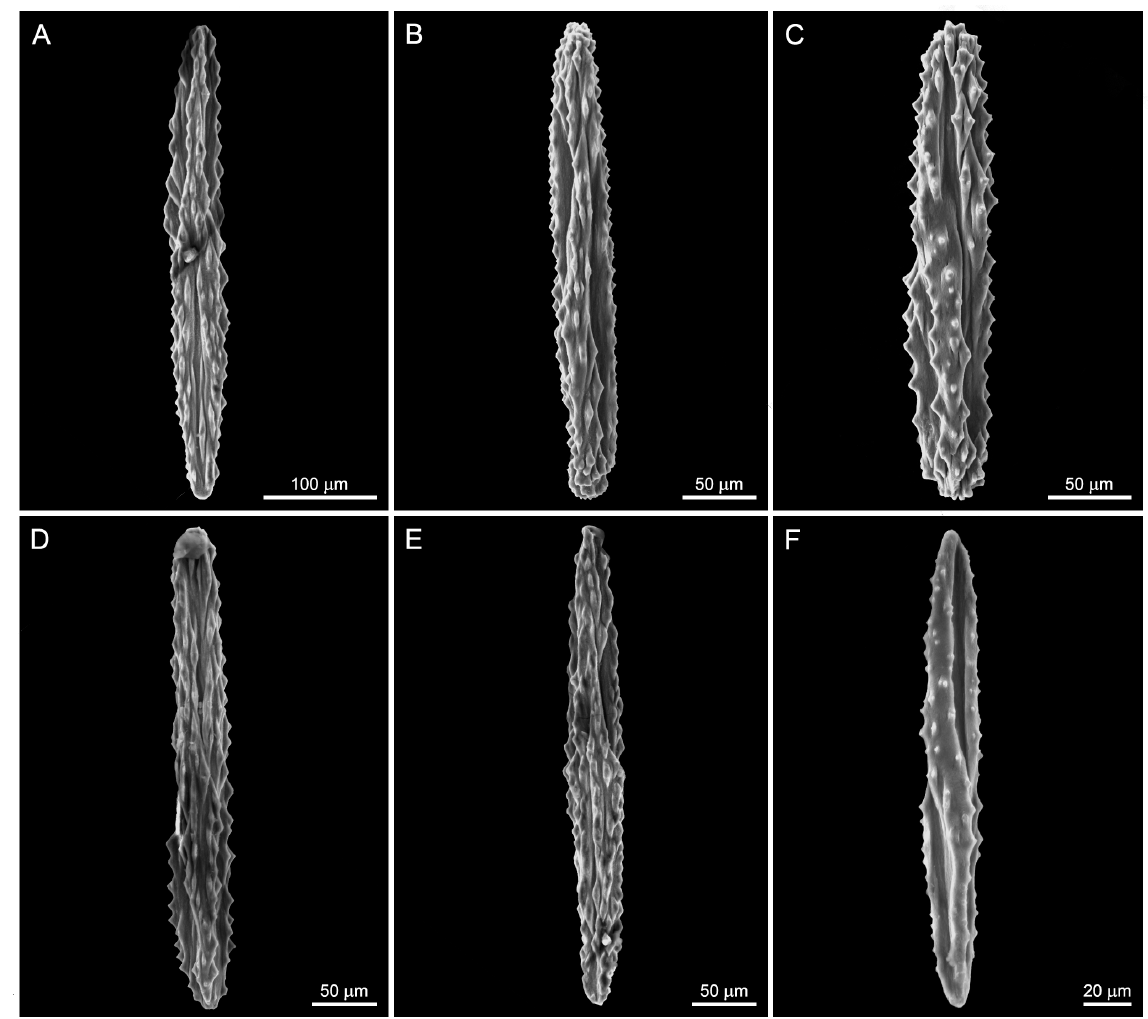
Fig. 4. Variability of sizes and ornamentations of the rachis’ sclerites of the holotype of Umbellula pomona Risaro, Williams & Lauretta sp. nov. (MACN-IN